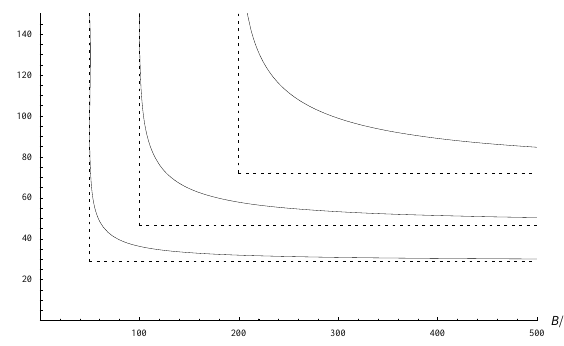
Fig. 4. Plot showing the normalized accelerating potential (cid:0) e8 (cid:14) kT (cid:1) required to produce a fixed normalised field-aligned cur- rent density (cid:0) j || (cid:14) j || o (cid:1) , versus the field ratio (cid:0) B (cid:14) B o (cid:1) , for a fixed un- accelerated population with temperature given by (as in Figs. 1–3). From bottom to top the three solid lines are for (cid:0) j (cid:14) j (cid:1) = 50, 100, and 200, respectively. For each curve, the cor- || || o responding horizontal dashed line shows the minimum accelerating potential given by the solution to Eq. (33), which applies in the limit (cid:0) B (cid:14) B (cid:1) →∞ (limit “B”). The vertical dashed lines show the min- o imum possible value of (cid:0) B (cid:14) B o (cid:1) (equal to (cid:0) j || (cid:14) j || o (cid:1) in each case), where the required potential diverges to infinity (limit “A”). It can be seen that the required voltages drop rapidly toward the minimum value for (cid:0) B (cid:14) B o (cid:1) values only modestly larger than the minimum, by factors of two or